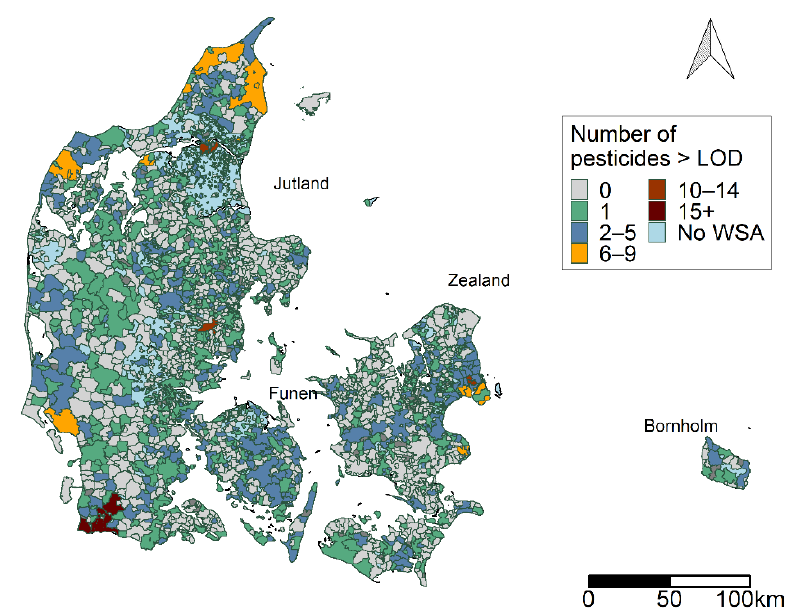
Figure 2. Locations of water supply areas (WSAs) in Denmark, classified by the number of pesticides detected at each WSA above the detection level (LOD) for the period 2002–2018. Map contains data from the Danish Agency for Data Supply and Efficiency, municipality borders, 2019.